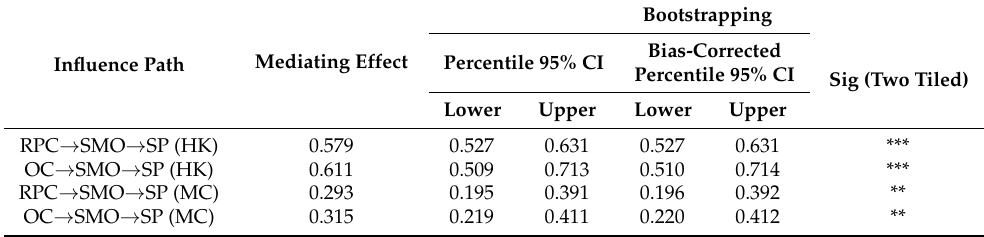
Table 9. Mediating effect of safety constructs in the influence mechanism of safety performance in Hong Kong and Mainland China.